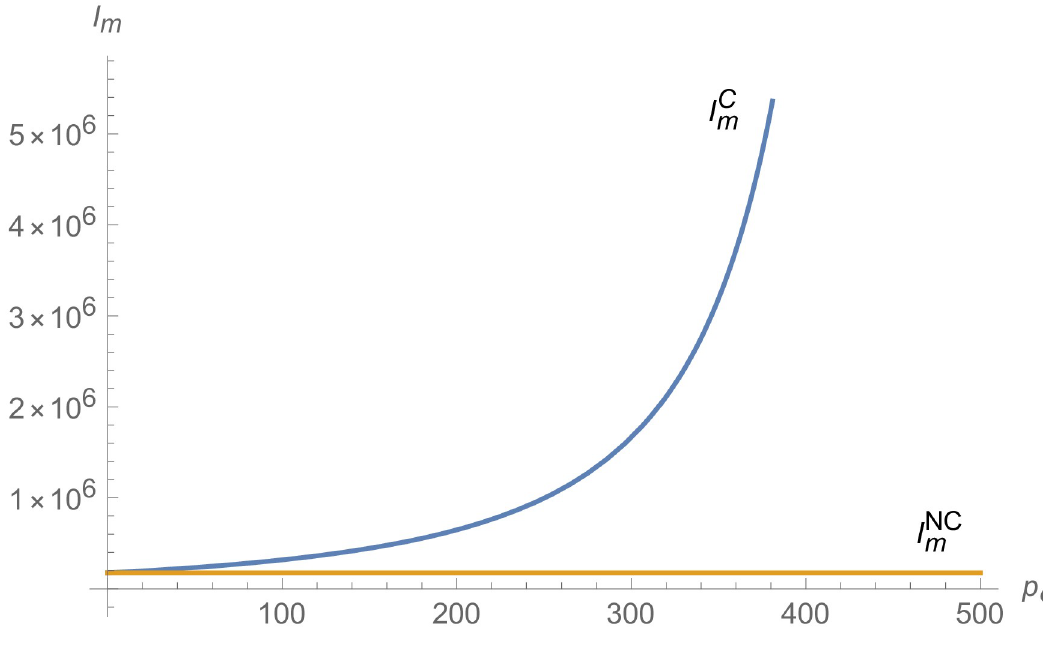
Fig 21. The impact of p